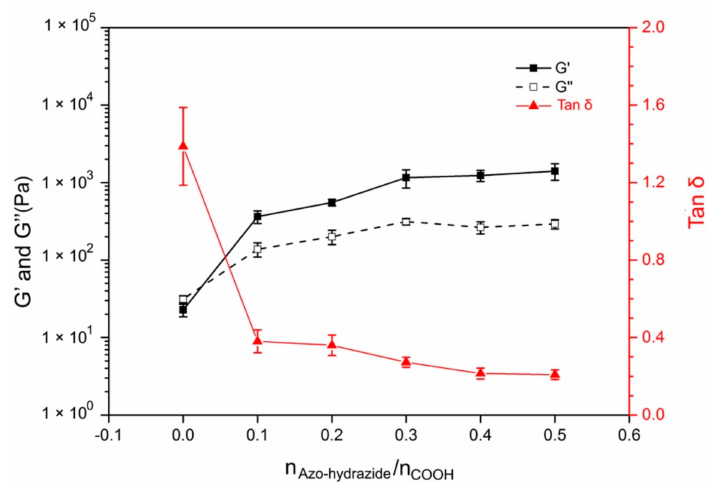
Figure 4. The e ff ect of the molar ratio of linker and alginate carboxyl groups on gel mechanical properties, where n Azo-hydrozide is the molar quantity of the added Azo-hydroazide, and n COOH is the total carboxyl group molar quantity in the gel. All samples were analyzed by a time-scan rheological test with a fixed frequency and strain of 50 Hz and 5% respectively.